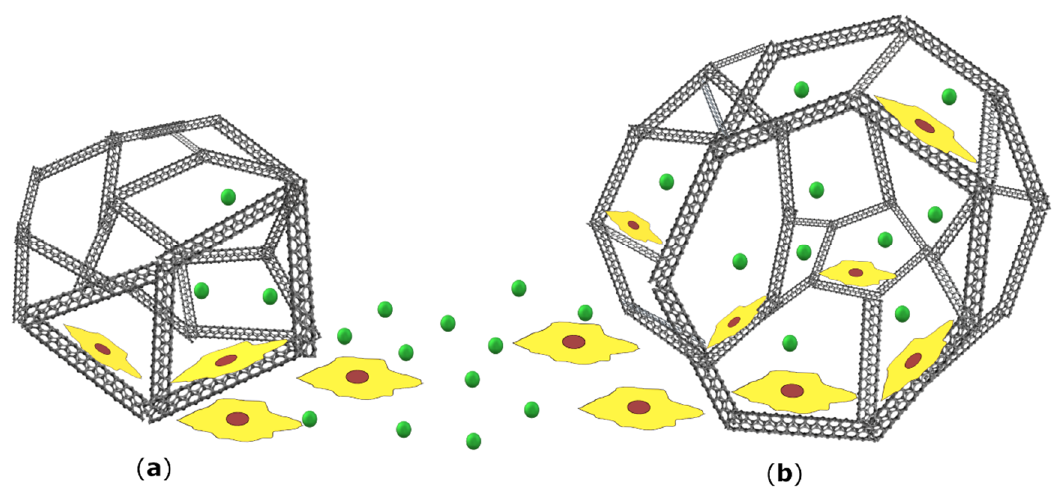
Figure 4. Porosity is a crucial factor in designing a scaffold. If pores are too small ( a ) there is a limited diffusion of nutrients and metabolites, as well as cell infiltration into deeper layers of the scaffold. However, such spatial constraint places cells near each other and therefore promotes proliferation, until the space becomes exhausted. On the other hand, if the pores are bigger ( b ) the flow of nutrients and cell penetration is much more efficient. Due to the low surface area, cell interactions and adhesion are exacerbated, which leads to slower cell proliferation. The figure is a schematic representation of a porous scaffold and it is not drawn to